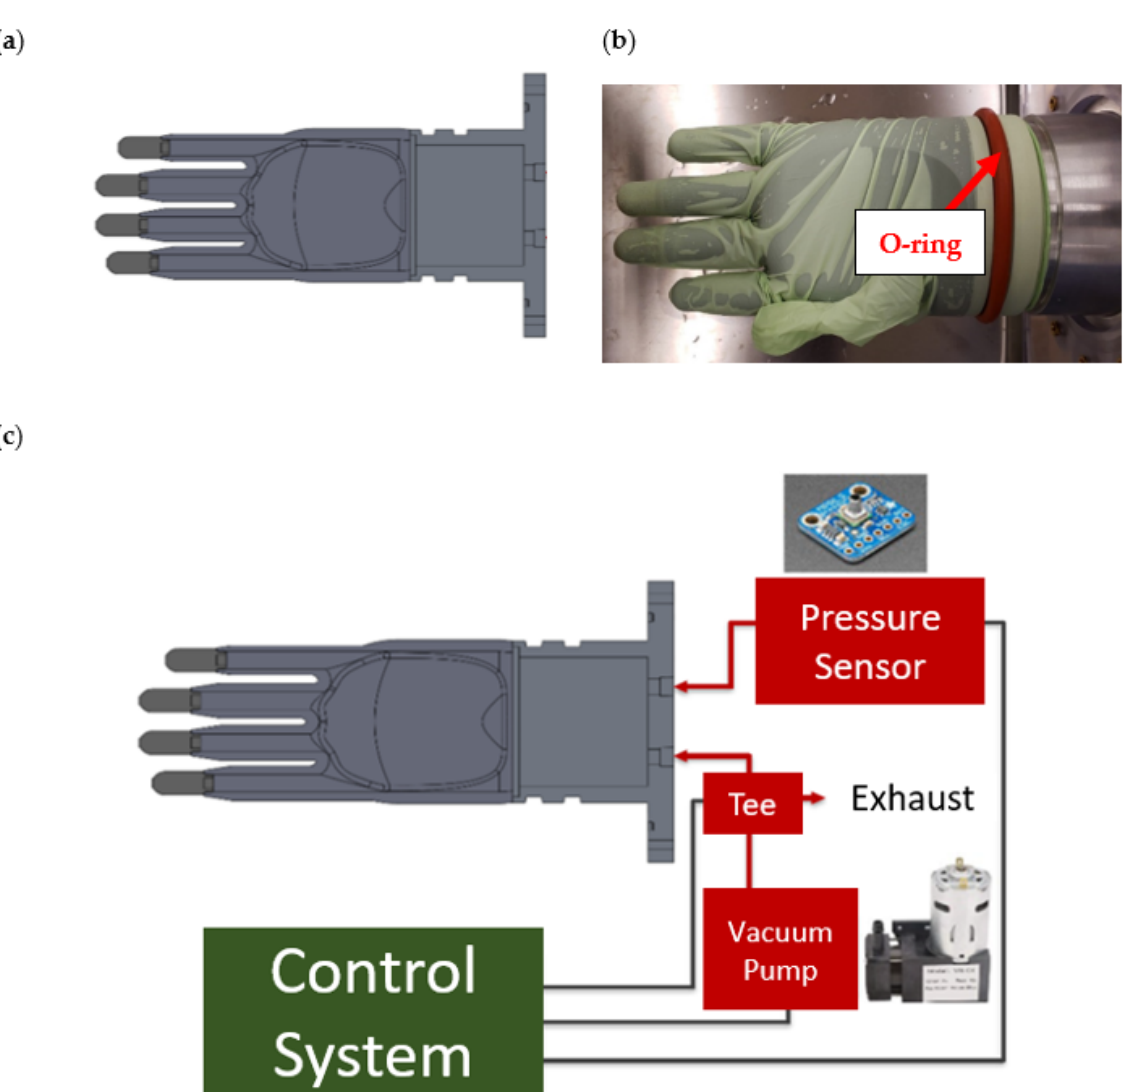
Figure 9. ( a ) AutoCAD model of 3D printed prosthetic hand. ( b ) Silicone O-ring applied to the base of the prosthetic hand. ( c ) Diagram of the connections between the prosthetic hand, vacuum pump, pressure sensor, and control system.